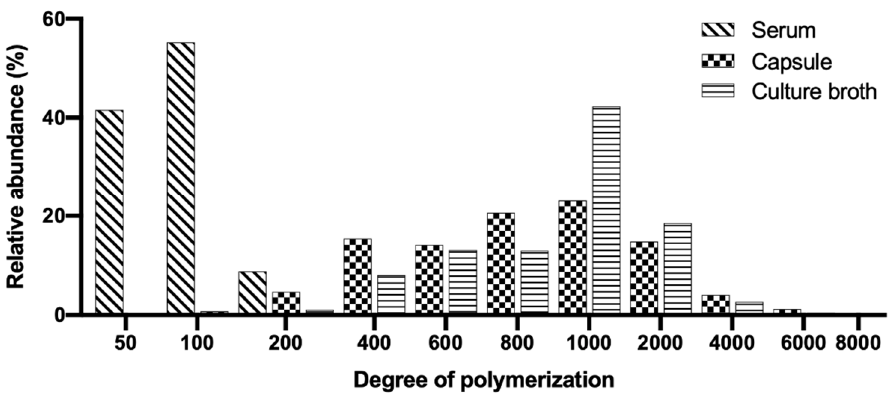
Figure 4. Histograms of HA in commercial samples and culture broth analyzed. Differential molecular weight distribution: molar fractions normalized to area = 100%.